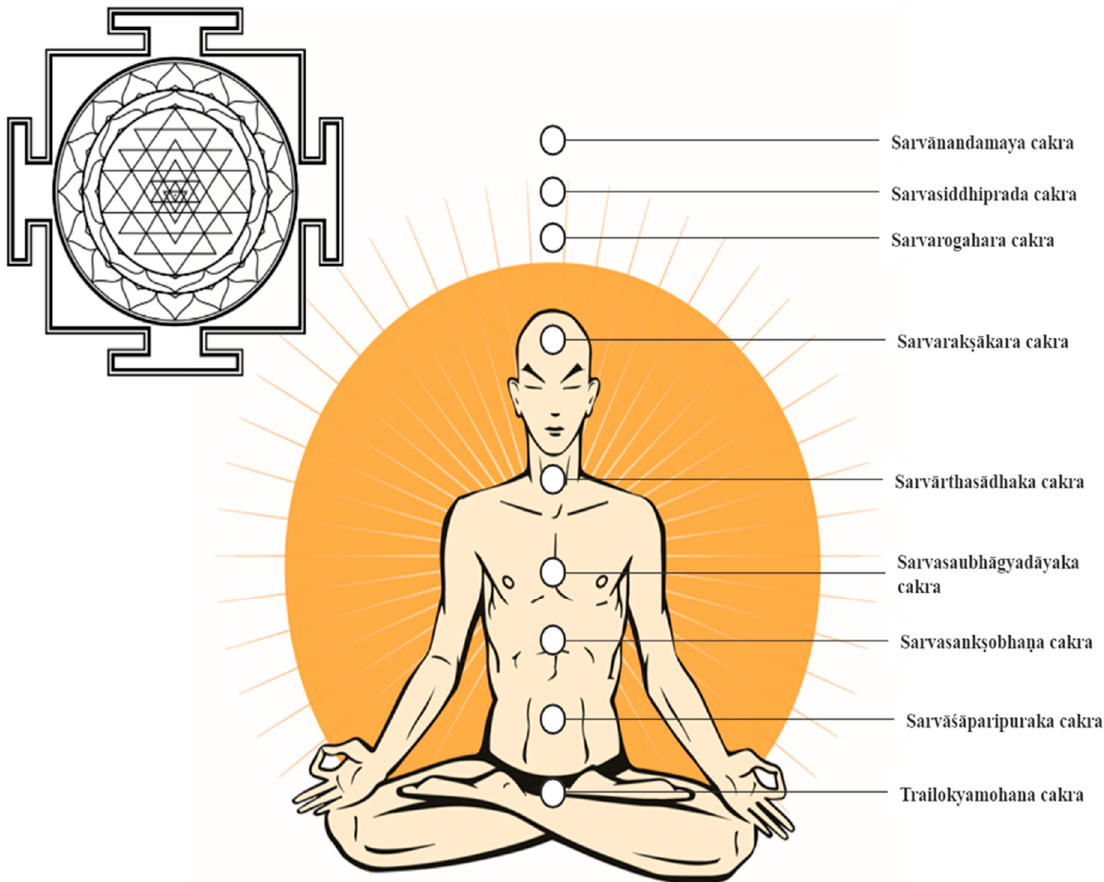
Figure 2. Correlation between the cakra s of the human body and the enclosures of Ś r ī cakra.